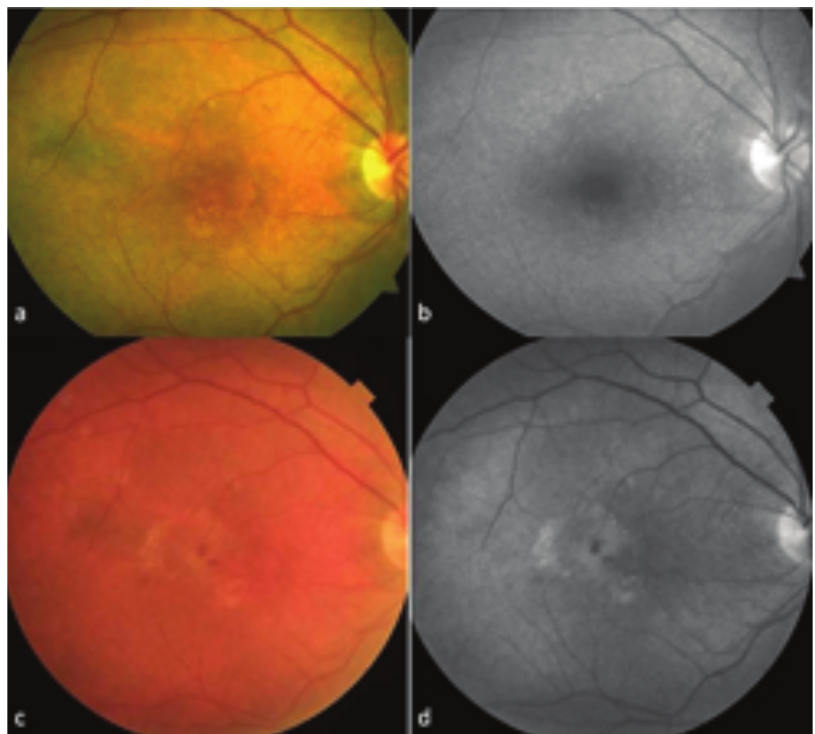
Figure 1. Multimodal imaging of a case of SDD. (a) Fundus photograph shows multiple dot-like regularly arranged array of whitish deposits predominantly in the perifoveal area. (b) The lesions are better delineated on blue channel or red-free photograph. (c) Fundus photograph after a year shows presence of intraretinal hemorrhage and neovascular membrane suggesting the development of retinal angiomatous proliferation. The number of SDD has decreased. (d) The red-free photograph reveals only a few SDD in the nasal macula, suggesting the regression of